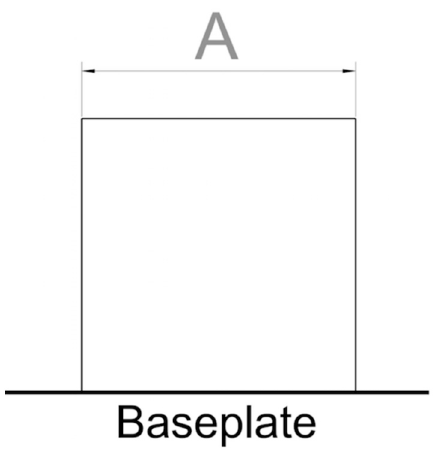
Figure 2 . Recommended specimen geometry to be used for assessing core bulk parameters. Figure 2. Recommended specimen geometry to be used for assessing core bulk